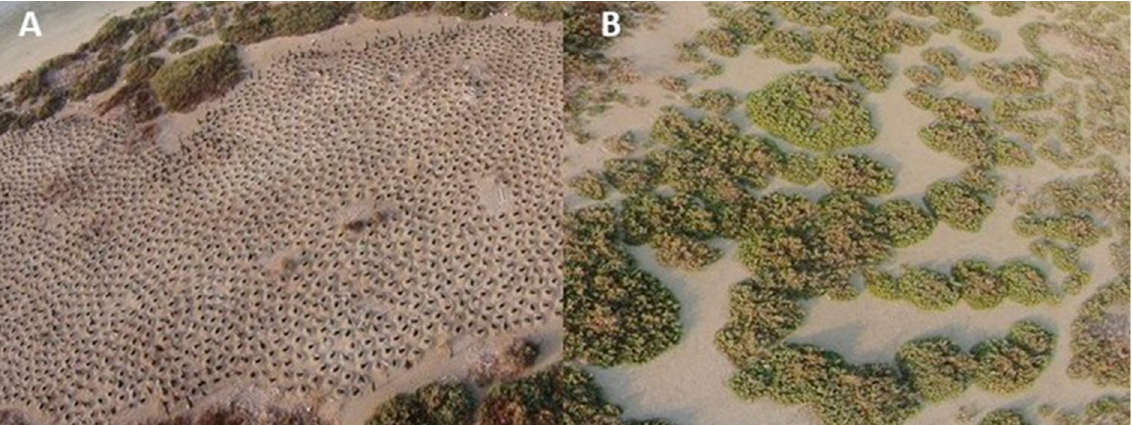
Figure 1. Aerial view of ( A ) nesting areas used by Socotra Cormorants showing individual nests (uniformly distributed dark shapes) in comparison with non-nesting areas ( B ) after nesting had occurred.